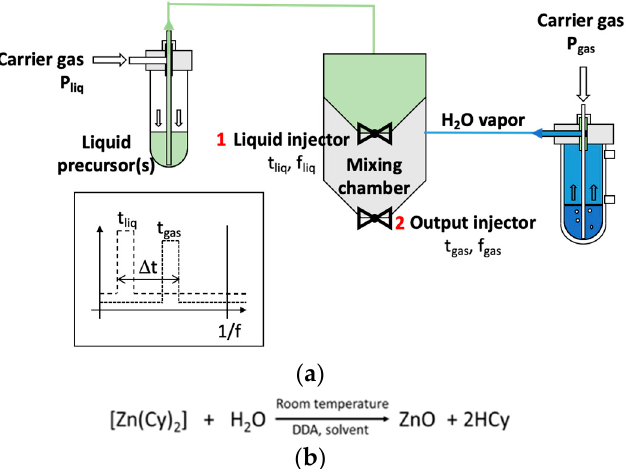
Figure 1. ( a ) Schematic diagram of the DLRI, the operating parameters and their temporal evolutions are defined in the box below. In this paper, ( b ) the hydrolysis of dicyclohexyl zinc is involved.